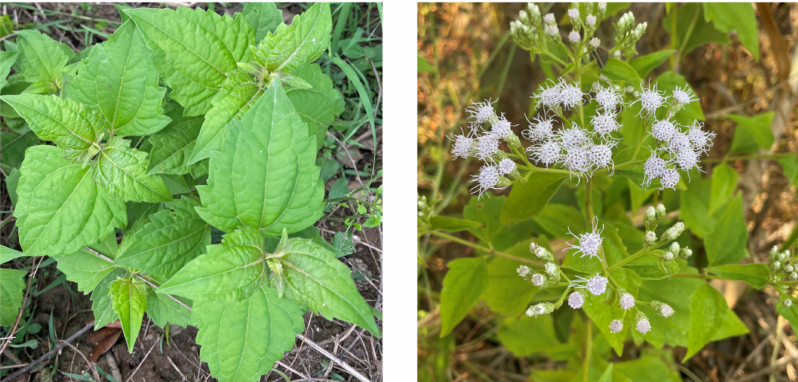
Figure 1. C. odorata; photos were kindly provided by Dr. Poonpaiboonpipat,